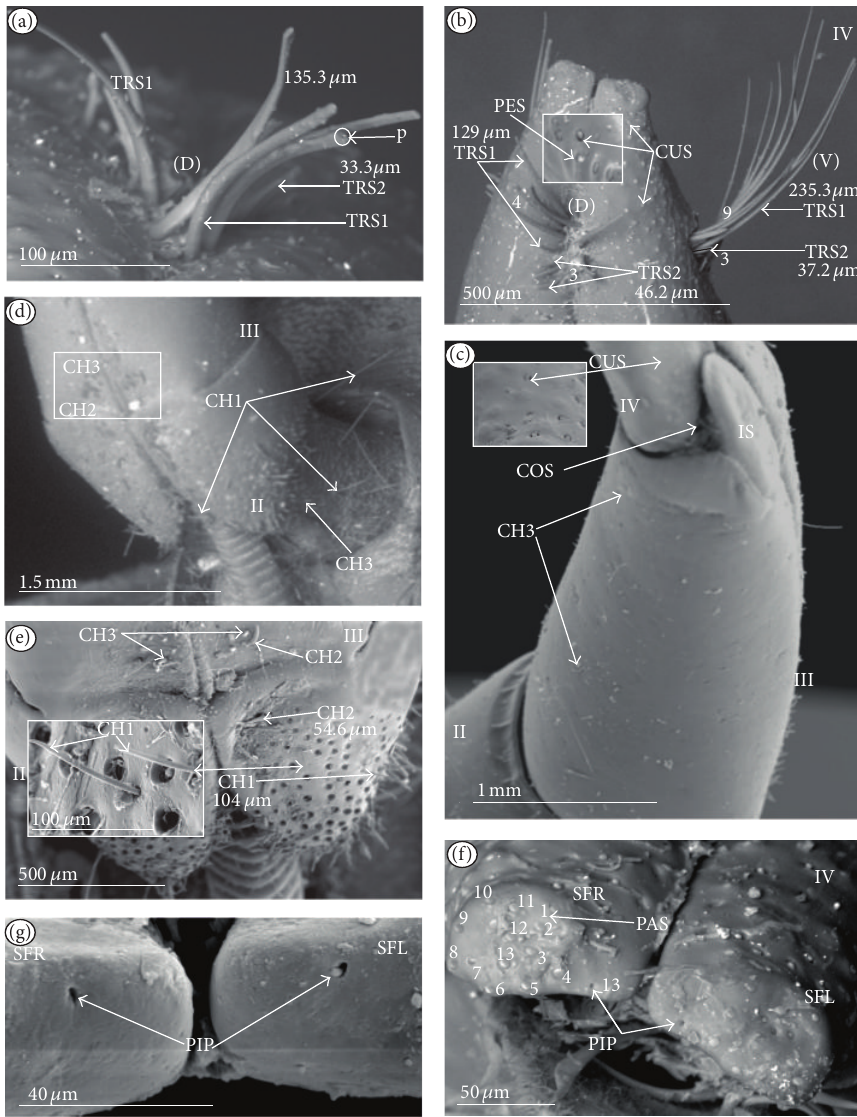
Figure 14: Types, sizes, and distribution of the sensilla of the Belostomatinae ( Lethocerus deyrollei ). (a) TRS2 and TRS1 are placed dorsally (D) near the apex of the labium; the pore (ap) is visible at the end of TRS1. (b) TRS2 (three), TRS1 (four) form a single row dorsally (D), TRS2 (three) and TRS1 (nine) form a tuft ventrally (V), and CUS and PES are numerous on the IV segment. (c) CH3 are spread sparsely on III segment, and COS is situated on segment IV and hidden under IS (intercalary sclerites) of the III segment. (d) CH1, CH2, and CH3 densely cover the dorsal and ventral surfaces of the labium on segments II and III. (e) CH3 and CH2 are less numerous and placed dorsally in a small group on segment III. CH1 are numerous on the dorsal surface of the II segment. (f) PAS1 (no. 1–13) and PIP (no. 14) are distributed apically over sensory fields (SFR, SFL). (g) PIP situated in the lateral positions on SRF and SFR are clearly